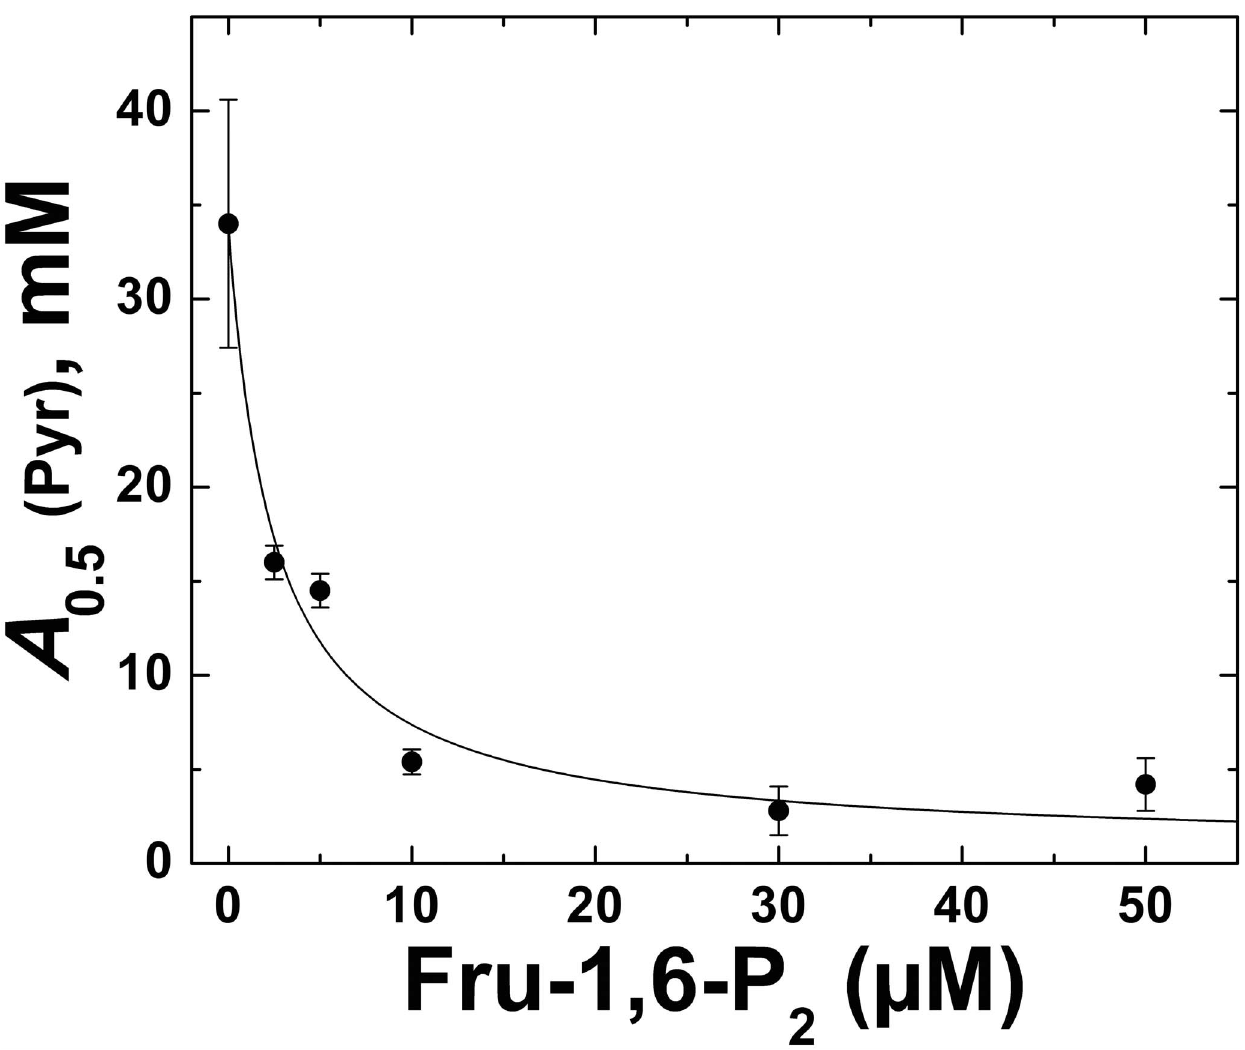
Figure 2. Effect of Fru-1,6-P 2 on the apparent affinity of ADP-Glc PPase for Pyr. Other conditions for the assays were as described under Materials and Methods. Values are the mean of three independent measurements 6 standard